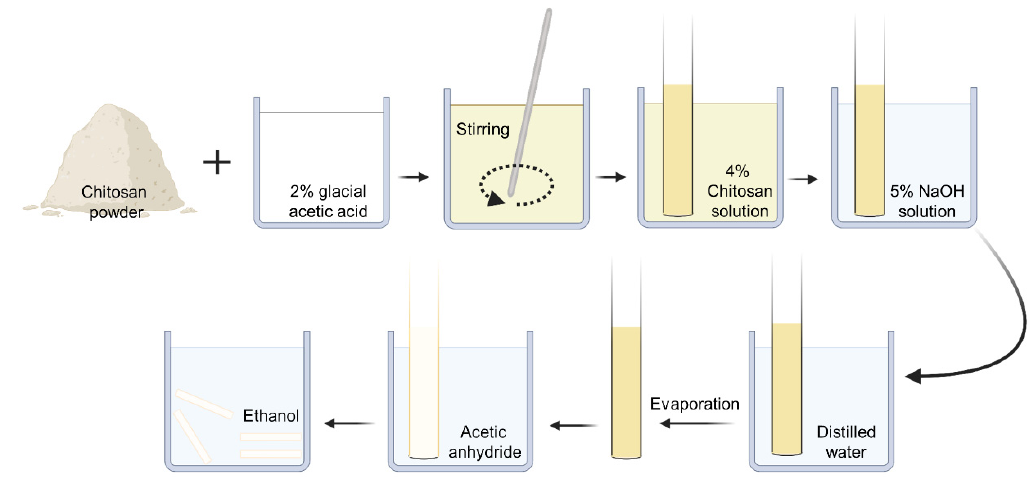
Figure 1. The construction process of chitin nerve conduits.